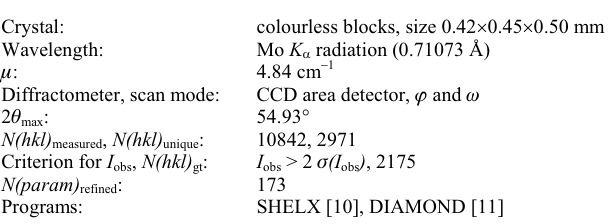
Table 1. Data collection and handling.